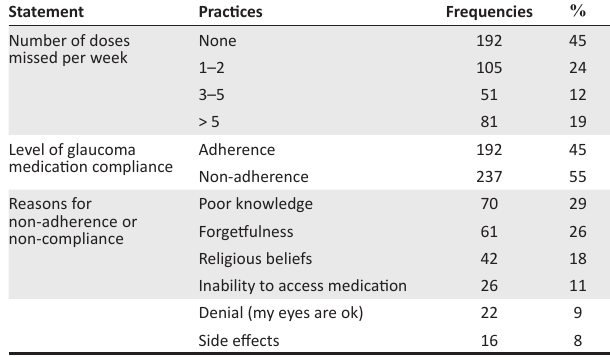
Table 4: Patients’ practice regarding glaucoma